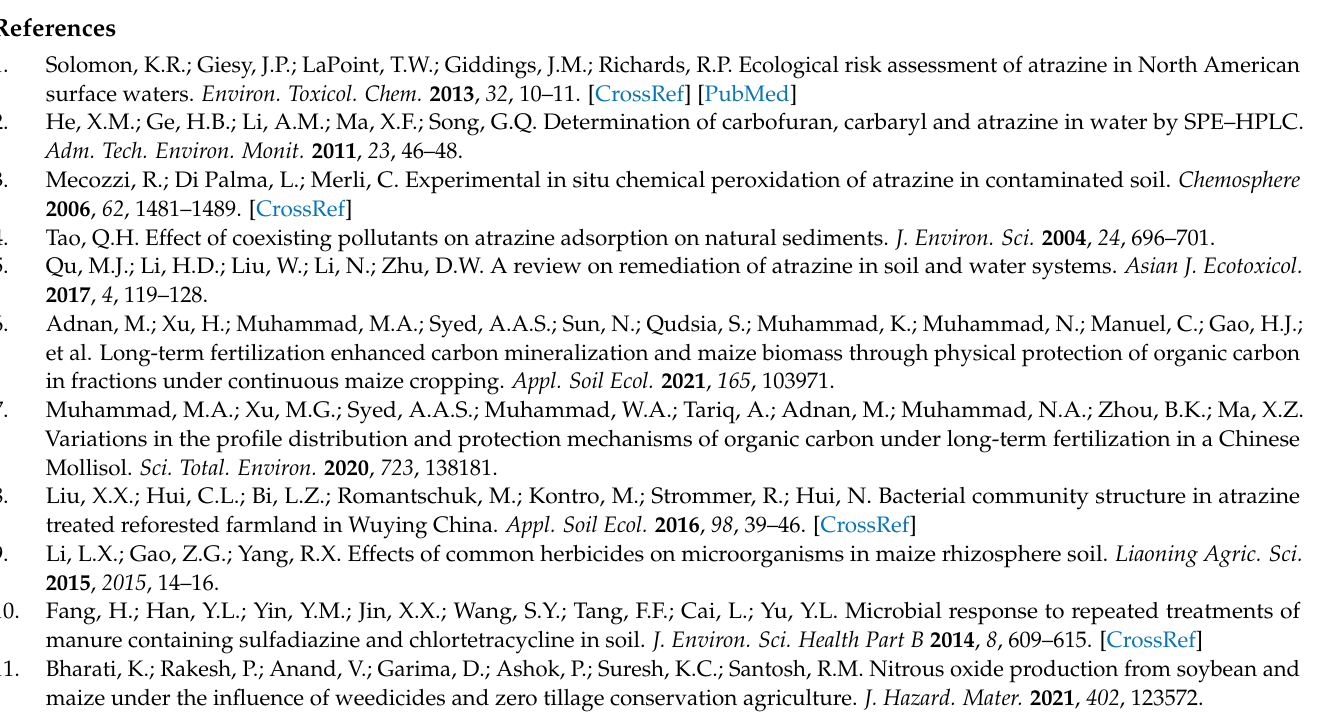
Principal component analysis. Figure S7: Wayne maps. Table S1: Classification of carbon sources on Biolog